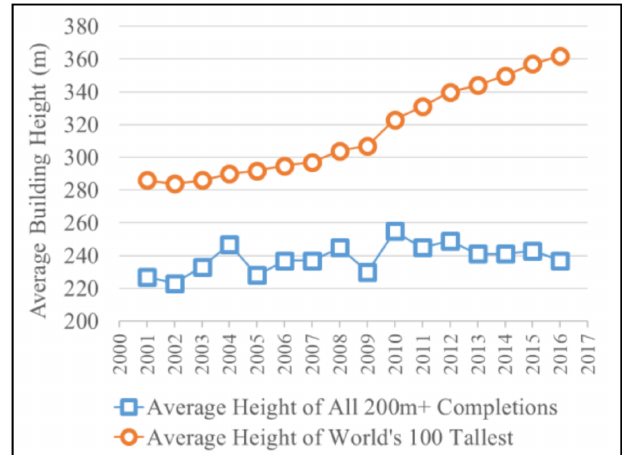
Figure 1. Average height of the tallest buildings.